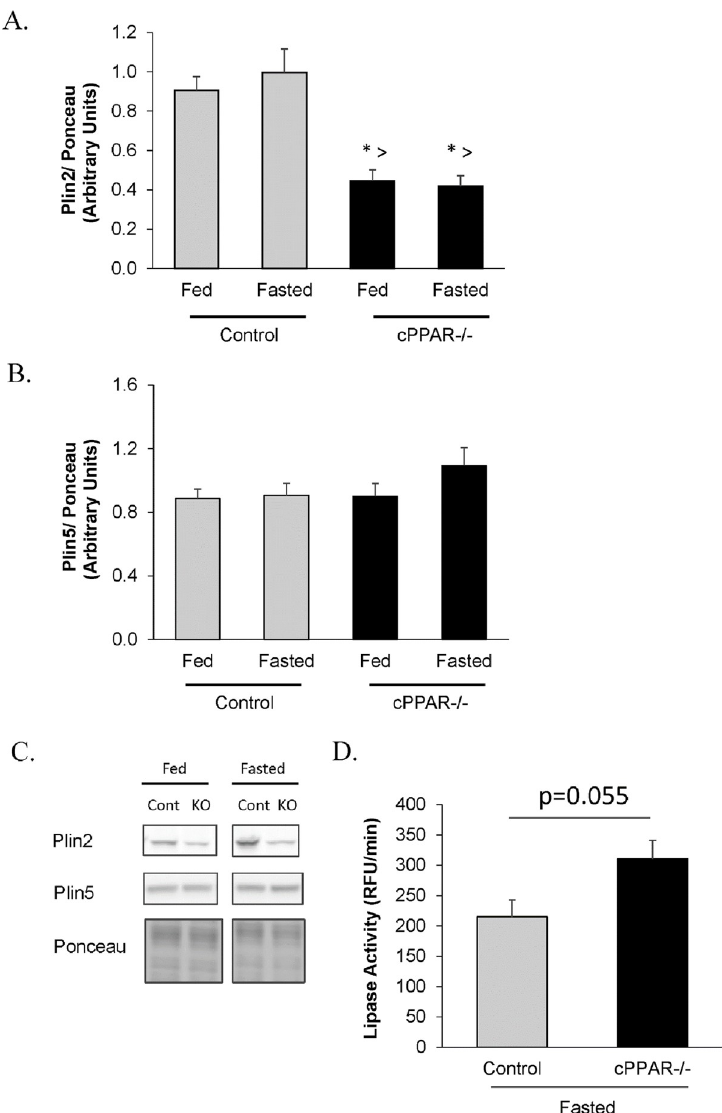
Fig 4. Reduction in myocardial PPAR α mice lowers cardiac Plin2. Mice were fasted for 16 hrs and A. Plin2 and B. Plin5 protein levels were measured in heart. C Representative western blots [Cont (Control); KO (cPPAR-/-)]. D. Lipase activity in heart. Values are mean ± SEM; n = 5–12; � p < 0.05 compared to Control Fed; > p < 0.05 compared to Control